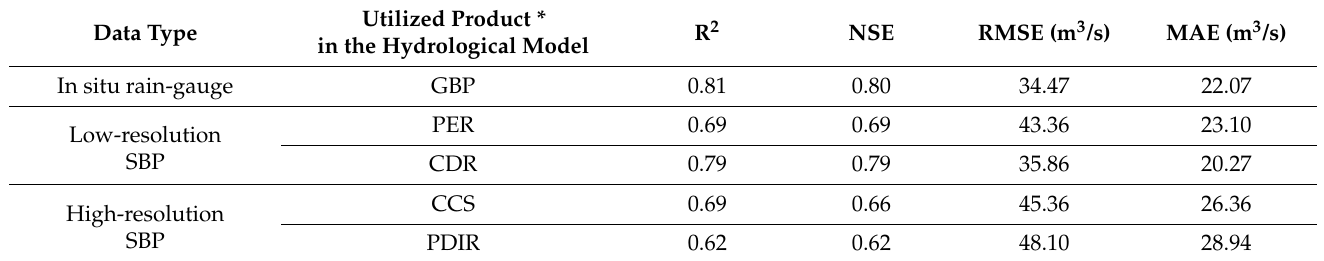
Table 6. The summary of the performances of HVEs (the testing period, 2009–2011 WY